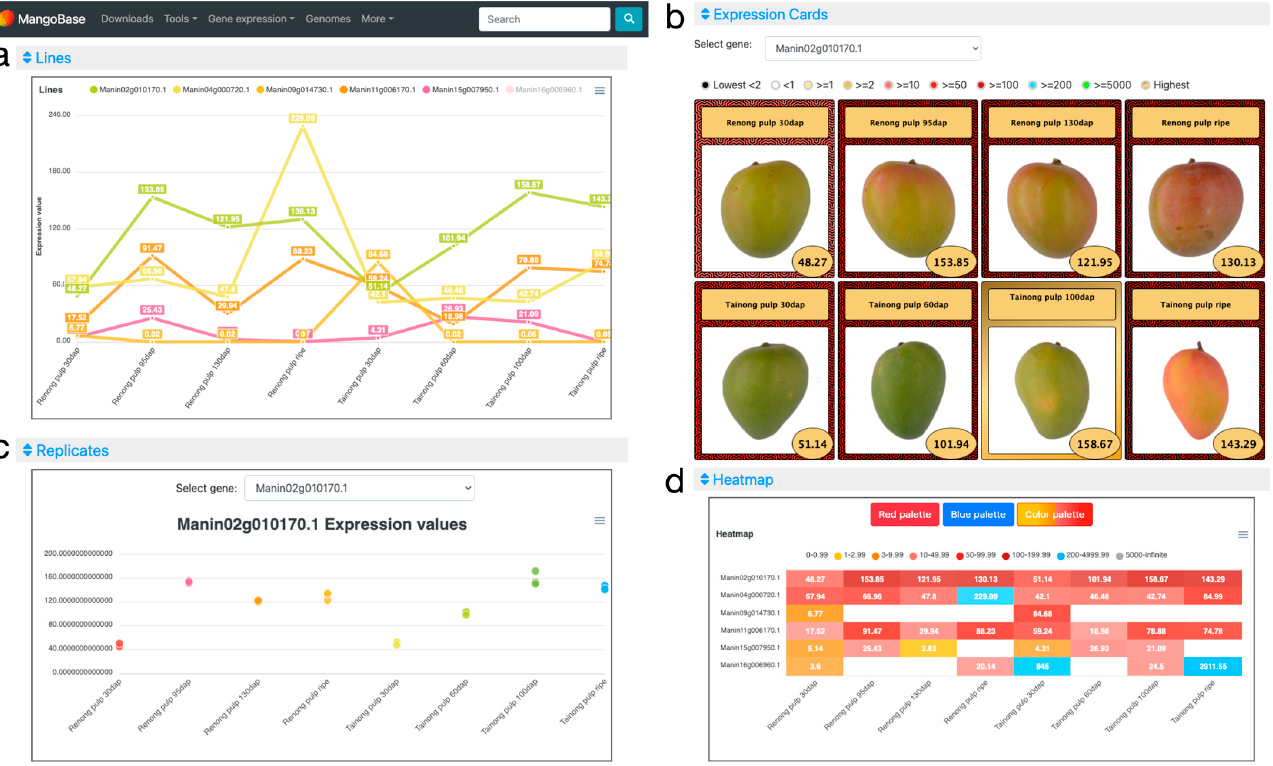
Figure 2. MangoBase gene expression atlas. ( a ) The Lines plot is useful to visualize and compare the expression of selected genes. ( b ) Expression cards showing experiment phenotypes of the selected gene. ( c ) The Replicates plot displays replicate expression values for each experiment of a selected gene. ( d ) Heatmap showing the expression of all genes and experiments grouped by expression